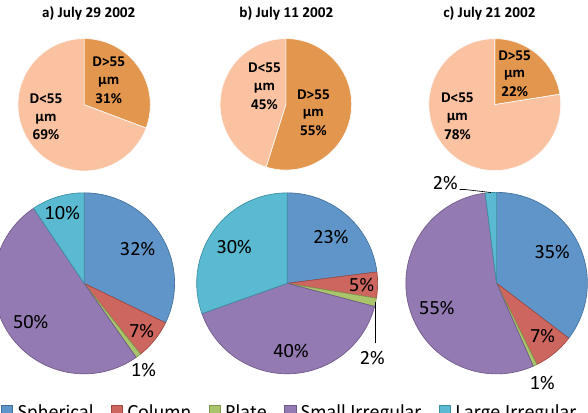
Large Irregular Fig. 4. Percentages of contribution to the total surface area from ice crystals with a maximum diameter smaller and larger than 55µm as determined by the CPI on the WB-57 (top pie diagrams), and percentages of CPI classifications according to total surface area (lower multi-colored pie diagrams, Lawson et al., 2001) for (a) 29 July (time t = 71 . 2–71.4ksUTC, height h = 12 . 5km); (b) 11 July ( t = 67 . 2–67.4ksUTC, h = 13 . 2km); and (c) 21 July ( t = 68 . 5– 68.6ksUTC, h = 14 . 1km).